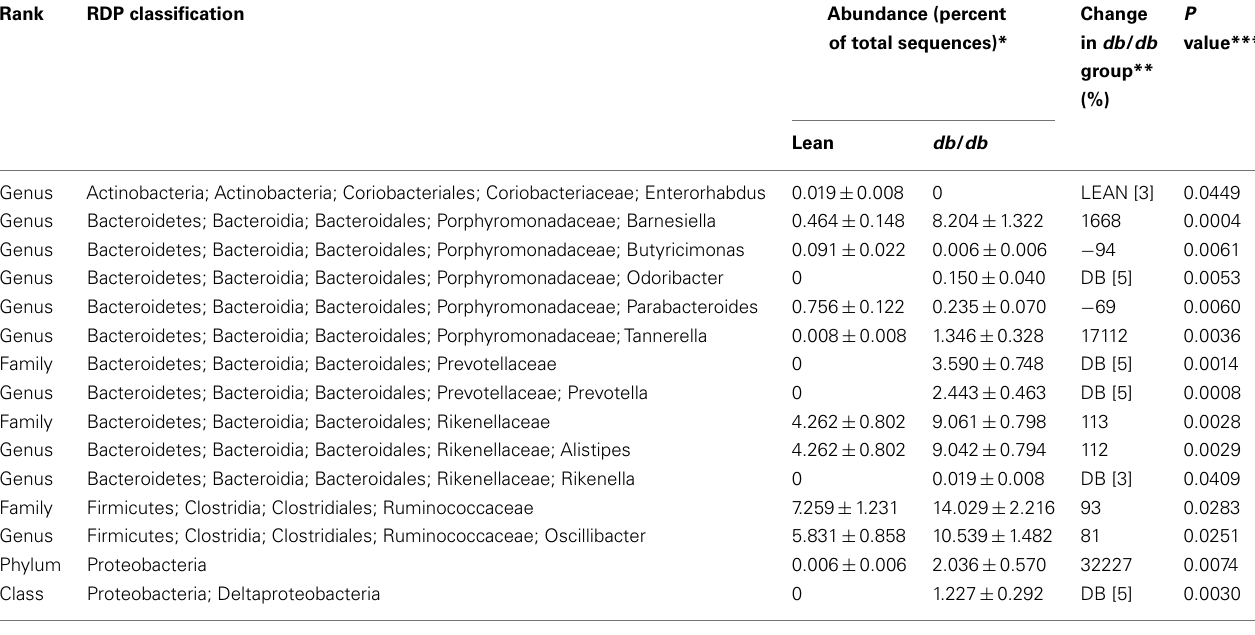
Table 1 | Taxa enriched or depleted in db / db